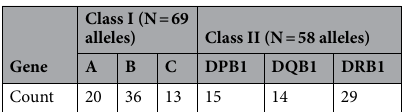
Table 3. Distribution of 127 HLA alleles analyzed to Class and